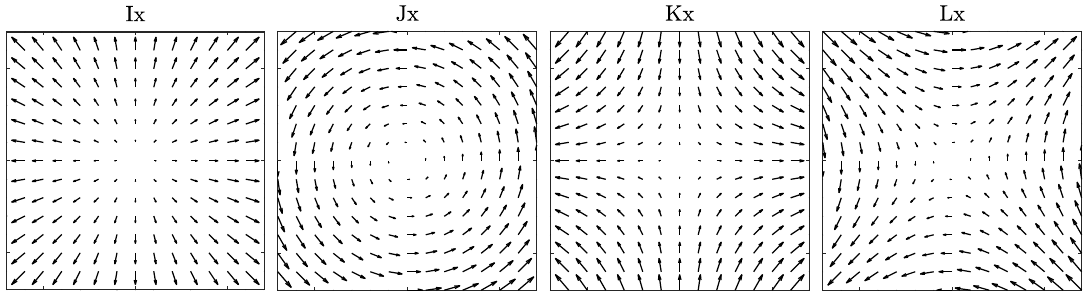
Figure 1. Matrix products associated with the IJKL matrices presented as quiver plots. From left to right, plots of Ix , Jx , Kx , and Lx are shown. These are the same as a velocity field of pure divergence, pure vorticity, pure normal strain and pure shear strain,